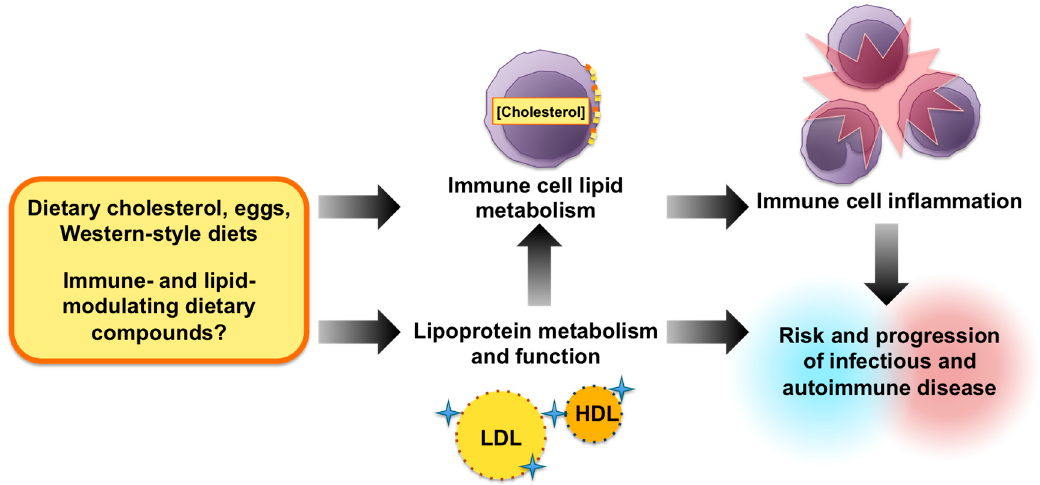
Figure 2. Proposed relationship between diet, lipid metabolism, and immune function in the pathophysiology of infectious and autoimmune disease.